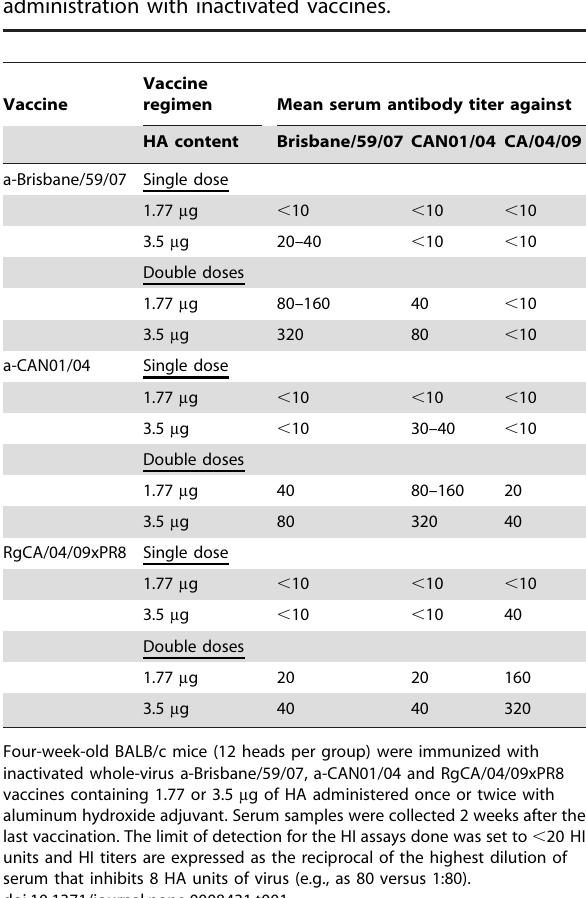
Table 2. Virus titers in the lungs of vaccinated mice. Table 1. Serum antibody response in mice after